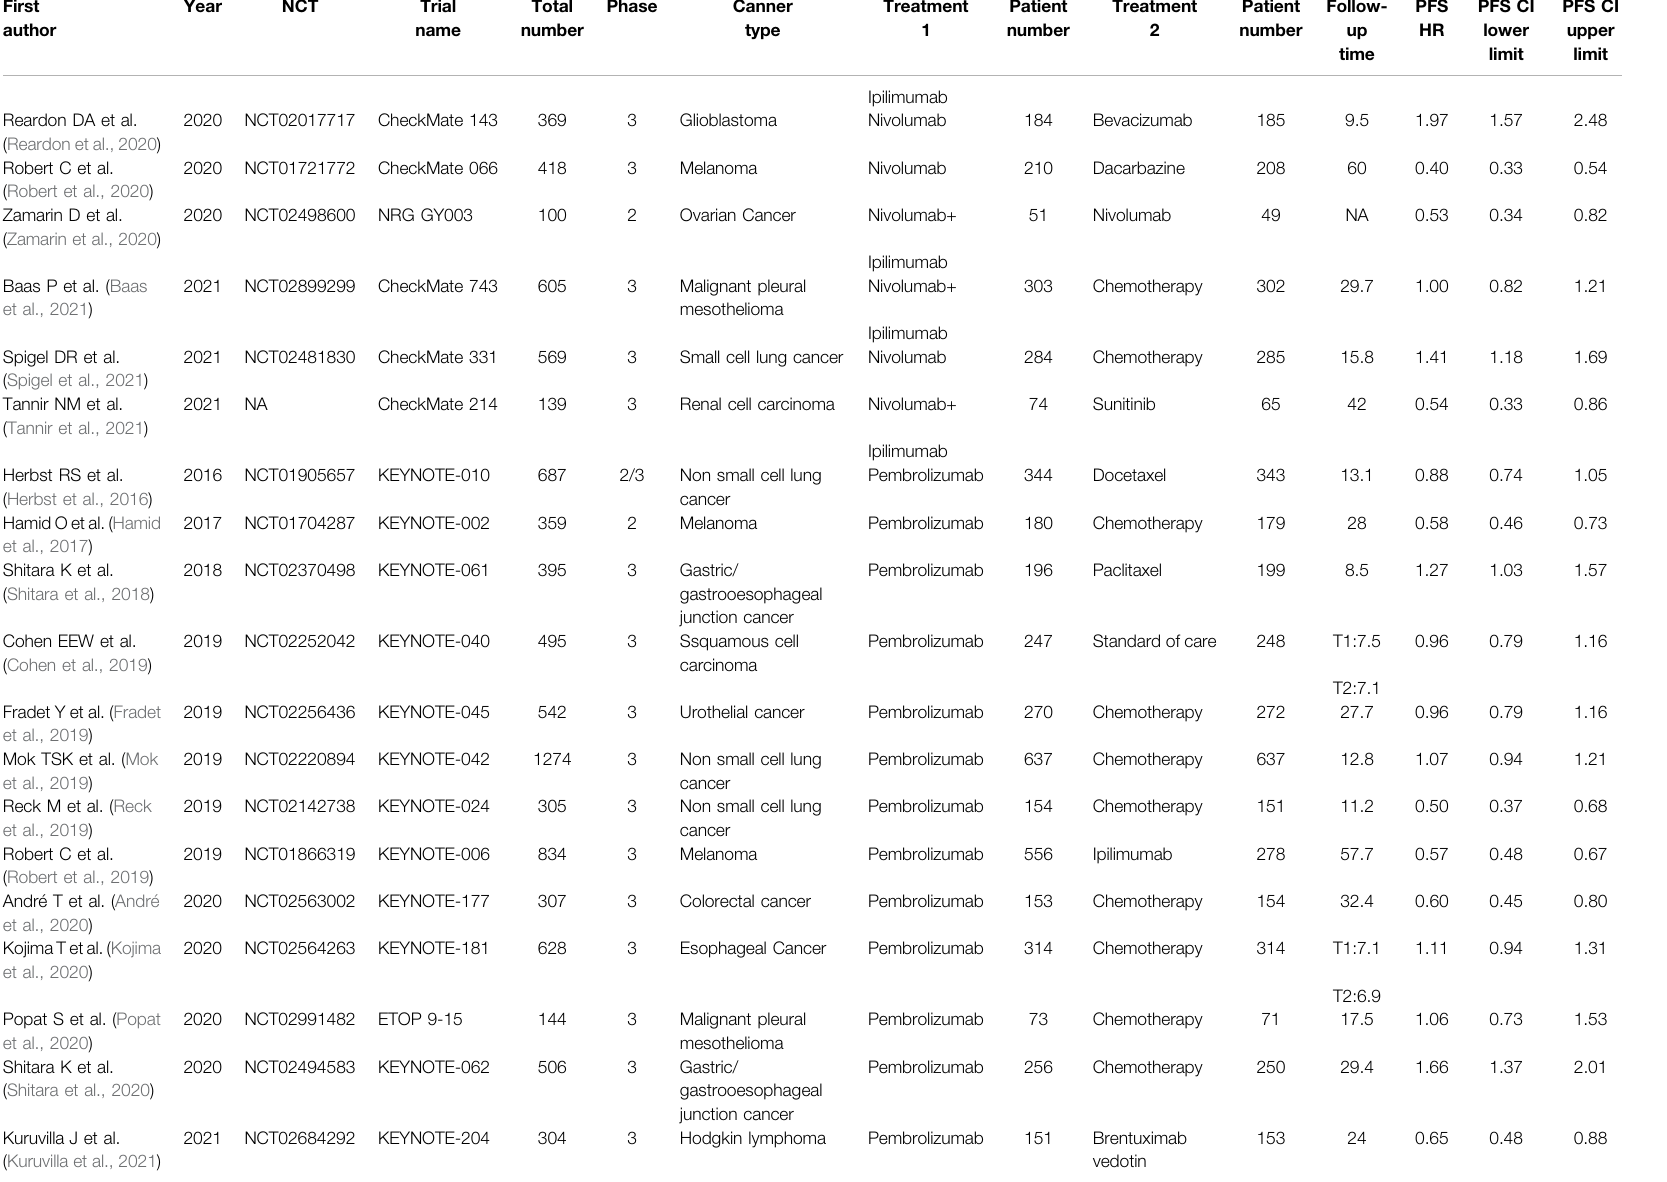
PFS = Progression-free survival. HR = Hazard ratio. CI = Con fi dence